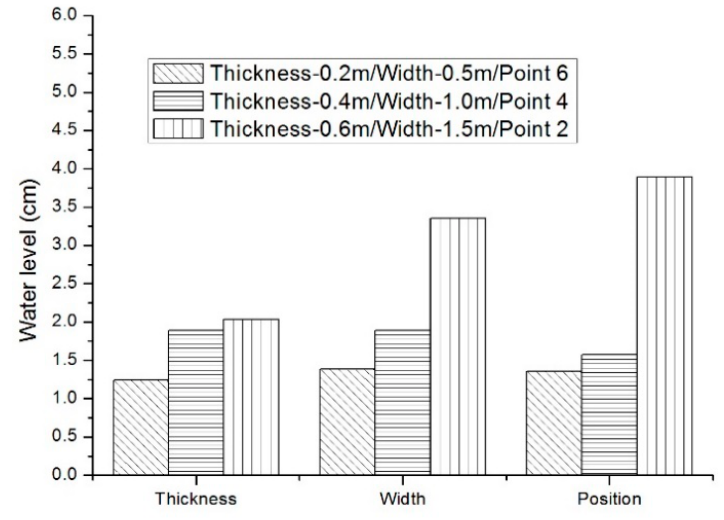
Figure 15. Comparative results for different configurations.